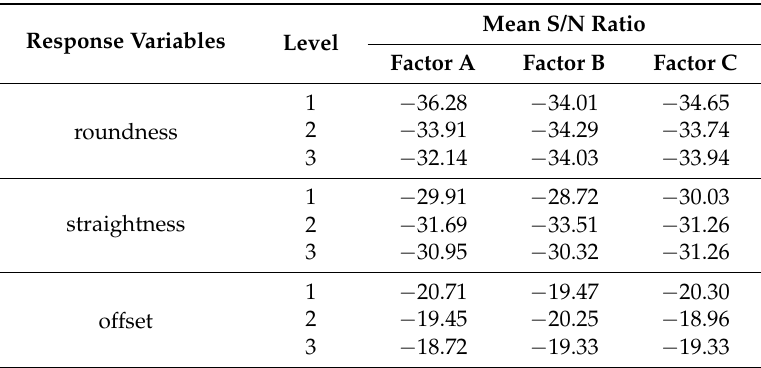
Table 5. Mean values at the same level of each factor and variable.